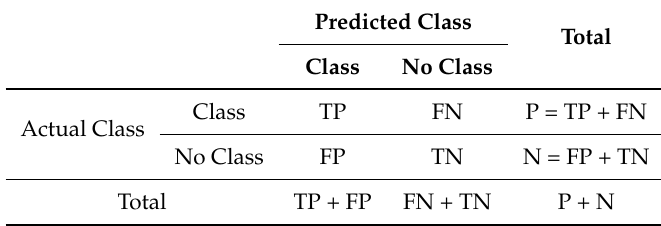
Table 2. Structure of a binary contingency